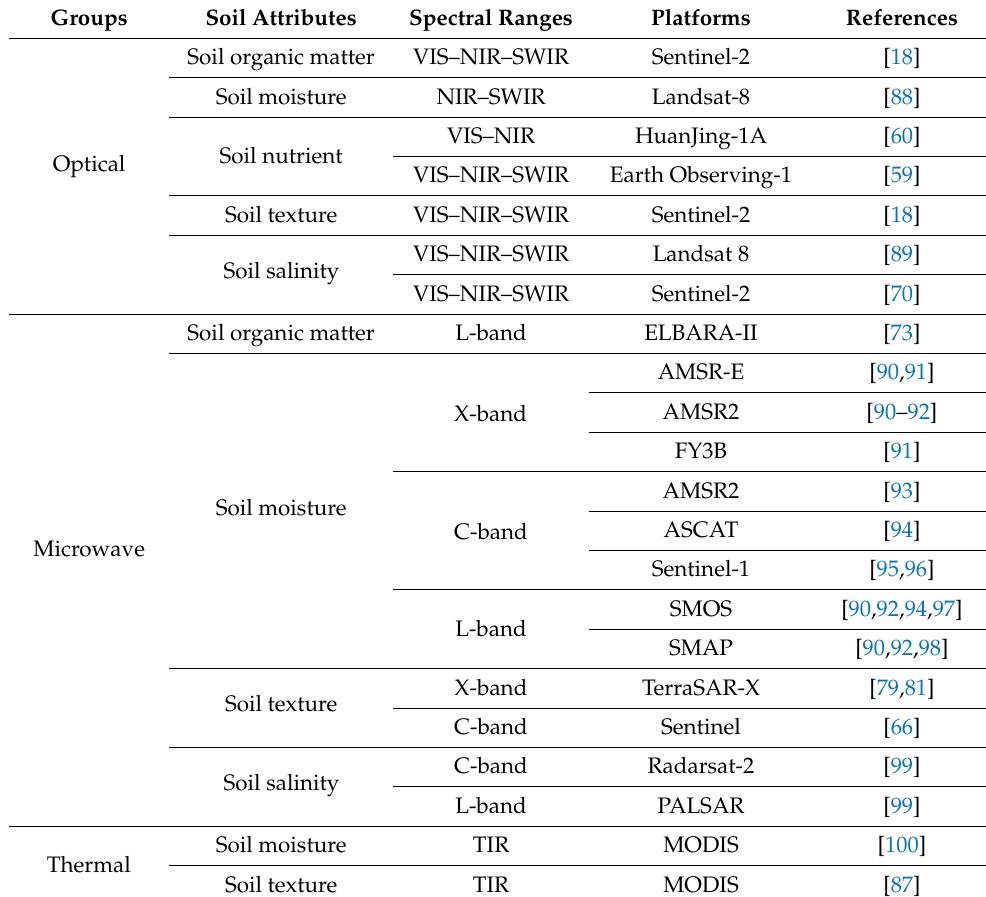
Table 1. The highlight of remote sensing groups and their applications in agricultural soil